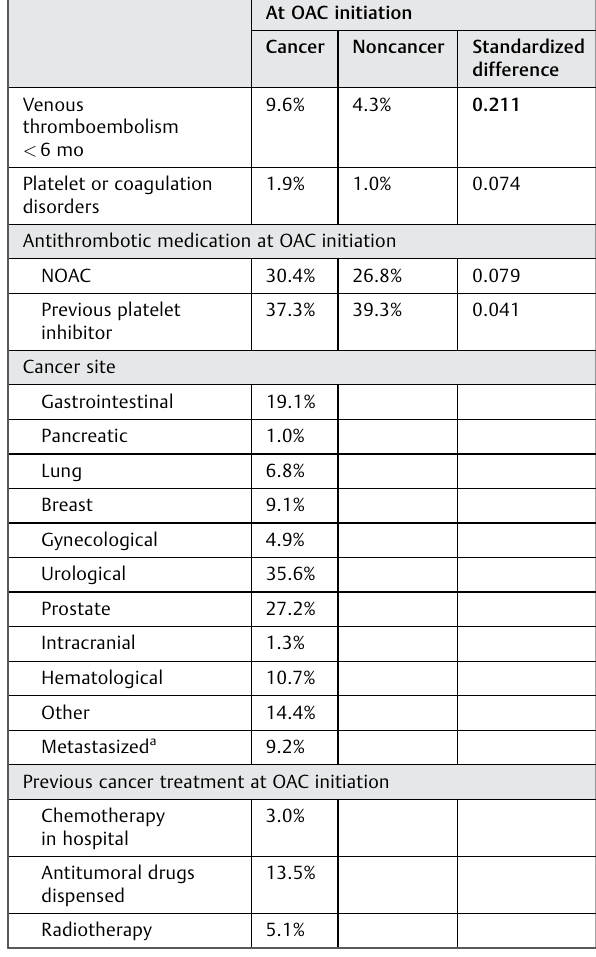
Table 1 Patients with atrial fi brillation, cancer versus noncancer: baseline data at OAC